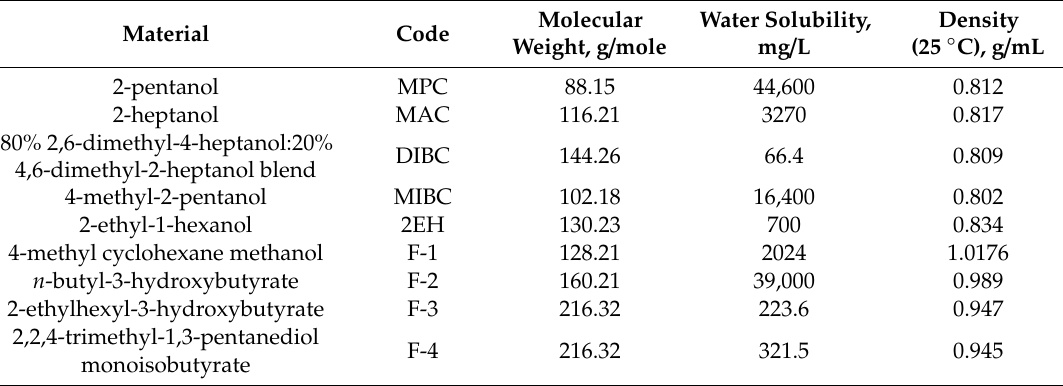
Figure 1. Chemical structures of the nine evaluated frothers. Table 1. Physical properties of all the nine evaluated frothers.